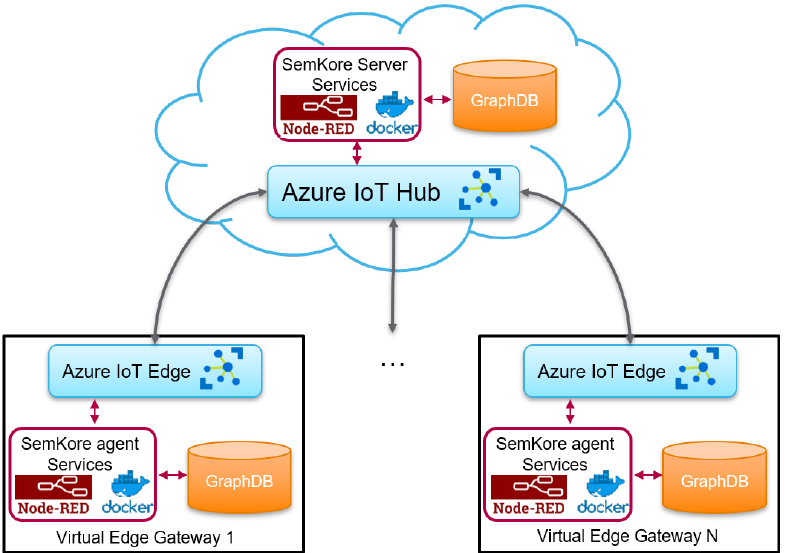
Figure 7. SemKoRe implementation setup. Simulated virtual edge gateways with SemKoRe Agents managed by a SemKoRe server instance hosted on the Microsoft Azure